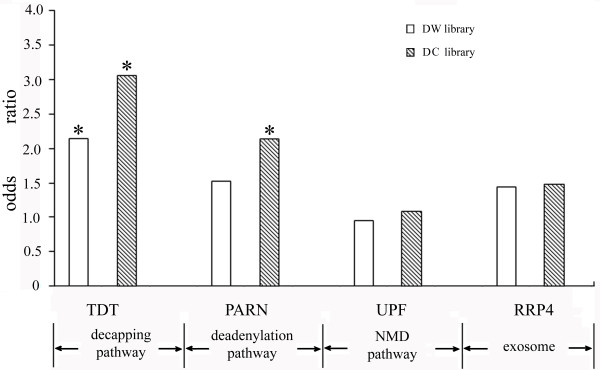
Enrichment analyses investigating the contribution of different decay pathways to PARE libraries. The enrichment for targets of mRNA degradation complex core components was analyzed in DW and DC library. Enrichment analyses for target sets, 88 genes for TDT (decapping complex), 135 genes for PARN (deadenylation complex), 58 genes for UPF (NMD complex), and 119 genes for RRP4 (exosome), were performed with Fisher's exact test. Significance of enrichments is showed by two-tailed P value. * indicates P < 0.001.